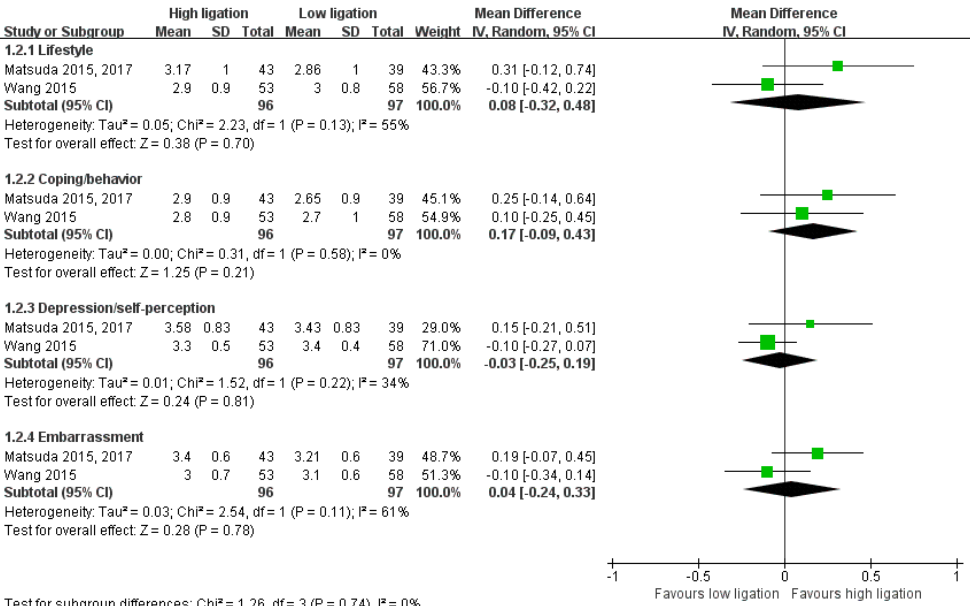
Figure 5. Forest plot of defecatory dysfunction assessed by each domain of the fecal incontinence quality of life scale (long-term) .